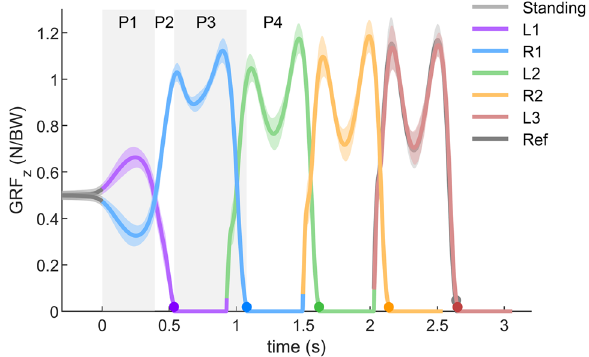
Figure 1. Vertical GRF ( GRF z ) during normal velocity gait initiation. GRF z is normalized to subject body weight (BW). The solid lines denote the average GRF z over 23 subjects. The error bands denote the ± 1 standard deviation. Time 0 is defined as the start of gait initiation. The dots denote the take-off (TO) moment. P1: weight shifting initiation phase; P2: leading limb lifting initiation phase; P3: trailing limb push-off phase; P4: stabilizing phase.